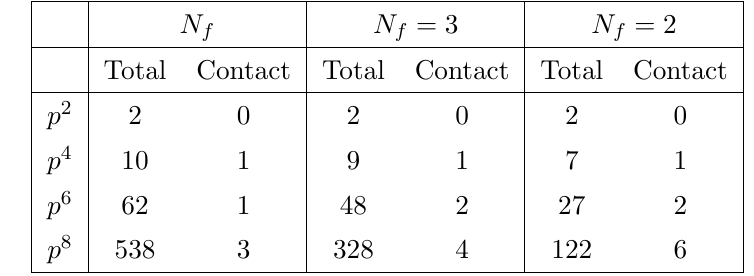
N N = 3 N = 2 f f f